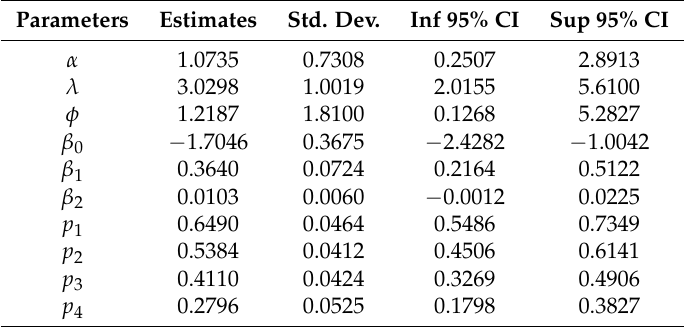
Table 4. MLEs of the Poisson Kumaraswamy Exponential model for the melanoma data set. Parameters